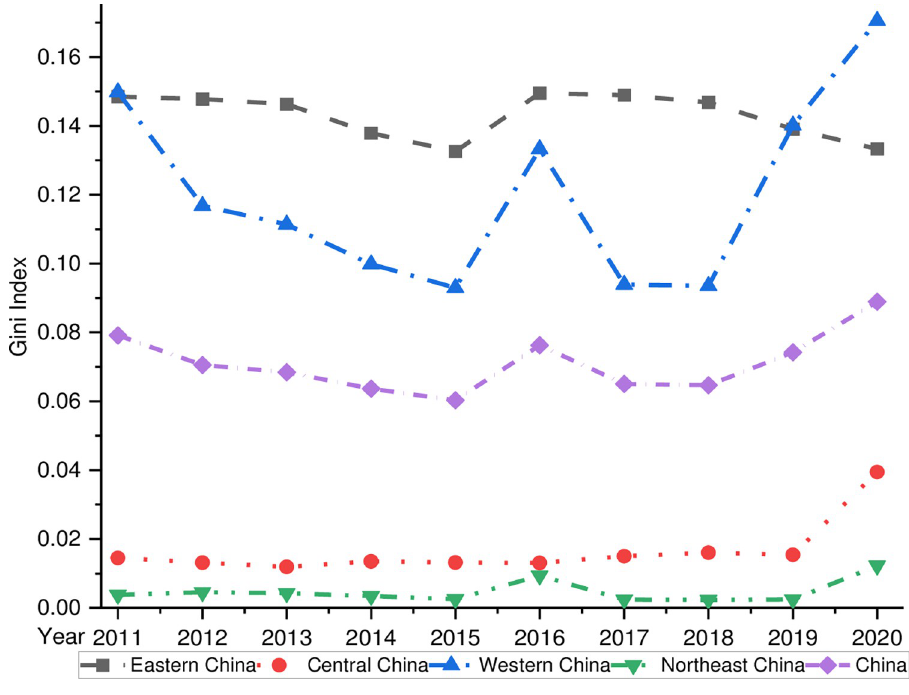
Fig 6. Overall Gini